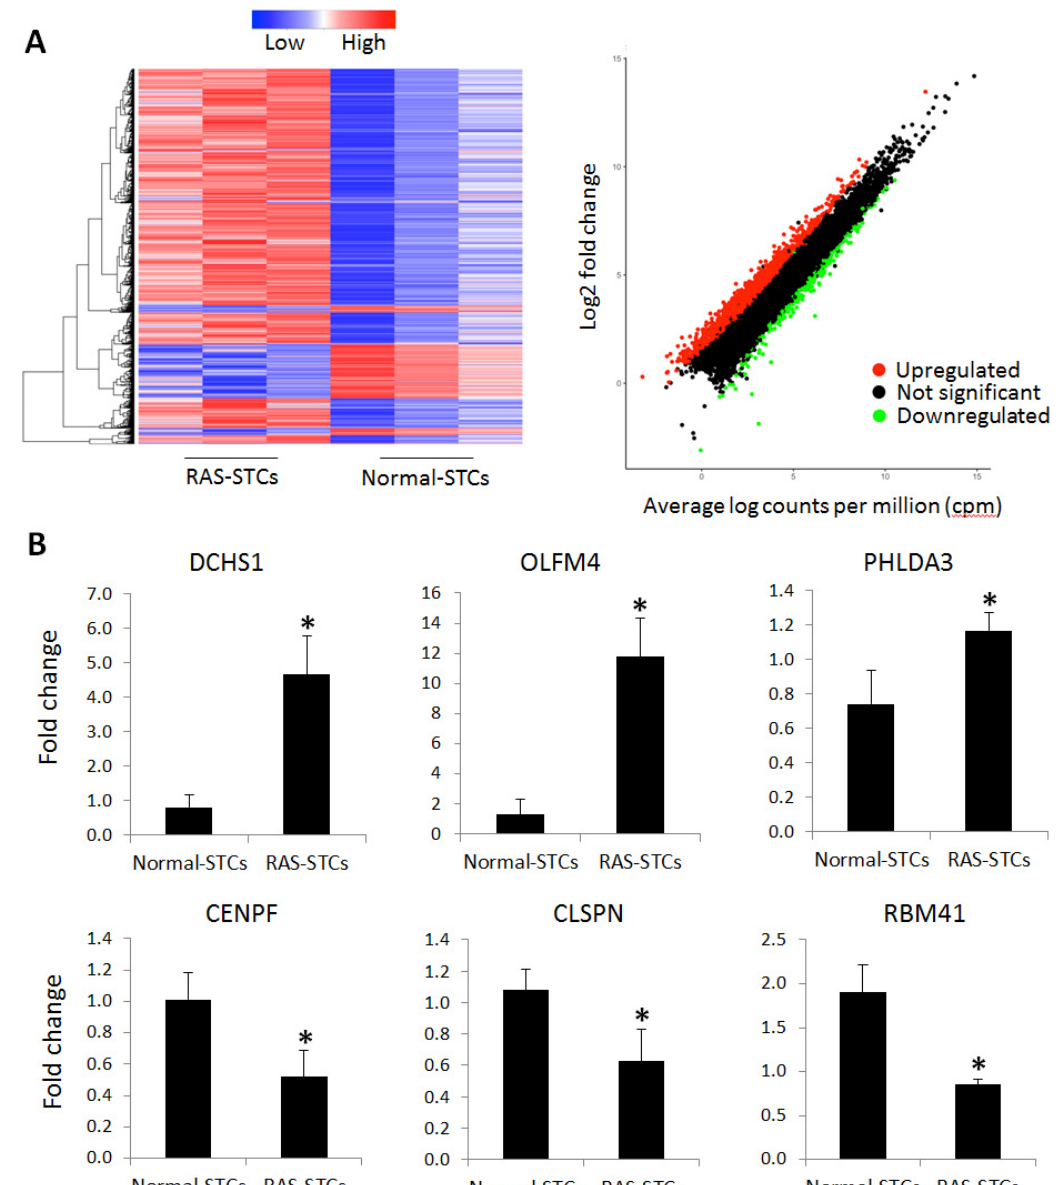
Figure 3. messenger RNA (mRNA) differentially expressed in renal artery stenosis (RAS)-scattered tubular-like cells (STCs). ( A ) Heat map and scatter plot showing 1,430 genes upregulated and 315 genes downregulated in RAS- versus Normal-STCs ( n = 3 each). ( B ) Expression of selected candidate genes followed the same patterns as the mRNA sequencing findings, where Dachsous Cadherin-Related 1 (DCHS1), Olfactomedin 4 (OLFM4), and Pleckstrin Homology Like Domain Family A Member 3 (PHLDA3) were upregulated and Centromere Protein F (CENPF), Claspin (CLSPN), and RNA Binding Motif Protein 41 (RBM41) were downregulated in RAS-STCs ( n = 3 each). * p < 0.05 vs. Normal-STCs.